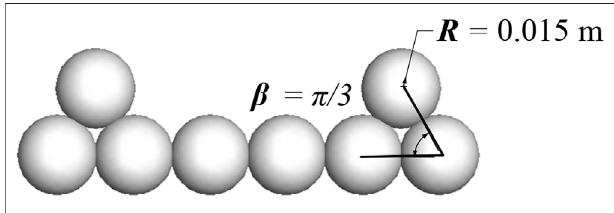
FIGURE2 | Shape ofparticleswith entangle angle β (cid:1) π /3 ofu-particles.